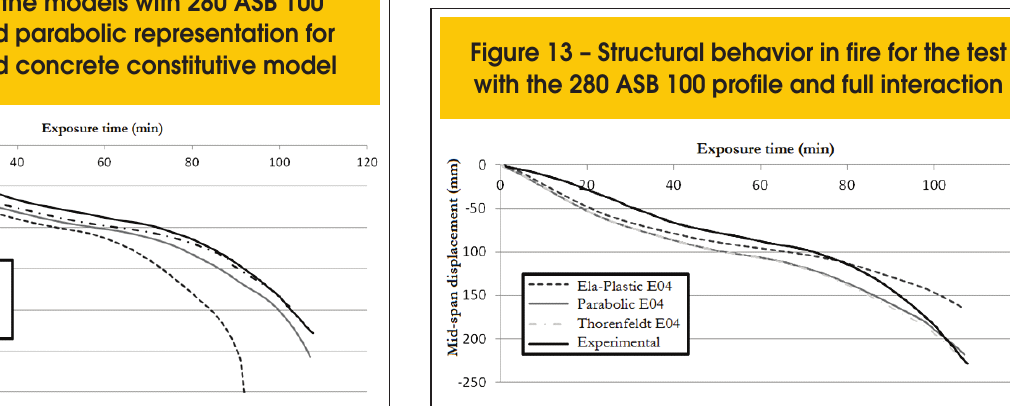
Figure 12 – Comparison of the thermal parameter hypothesis for the models with 280 ASB 100